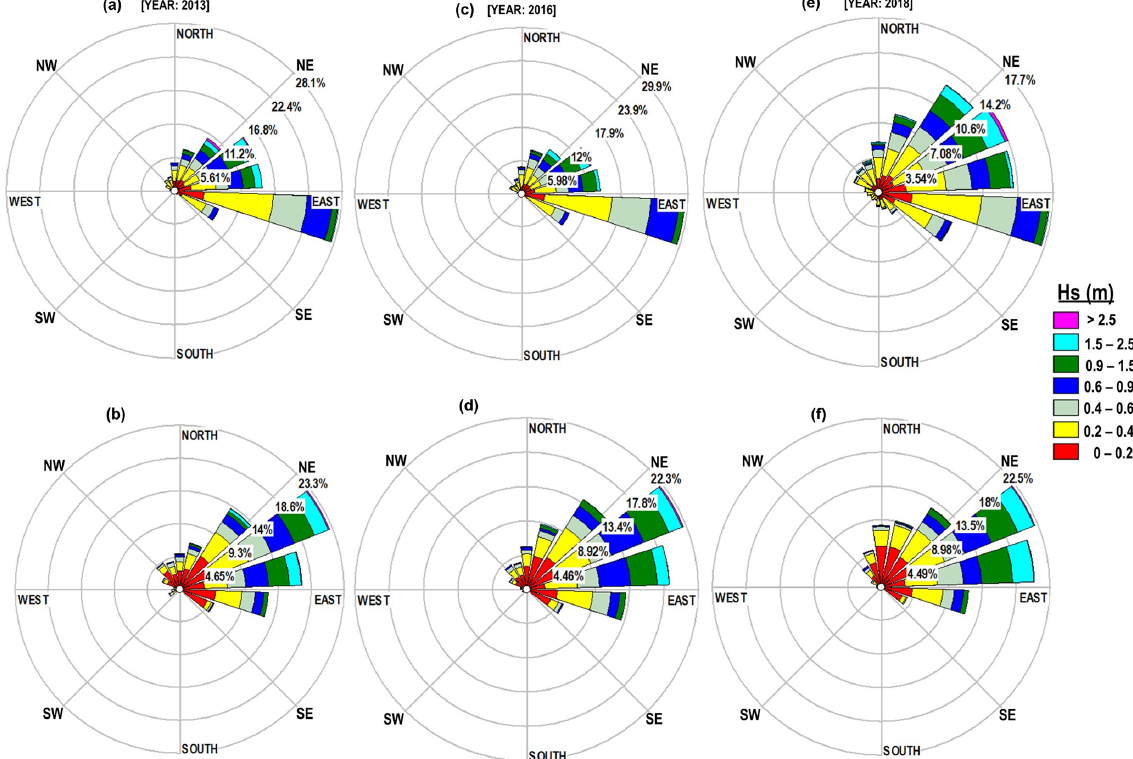
Figure 8. Comparison of directional histograms of wave heights: buoy (a, c, e) , and simulated (b, d, f) data at Cesenatico, station 6 (NE: north- east; SE: southeast; SW: southwest; NW: northwest).